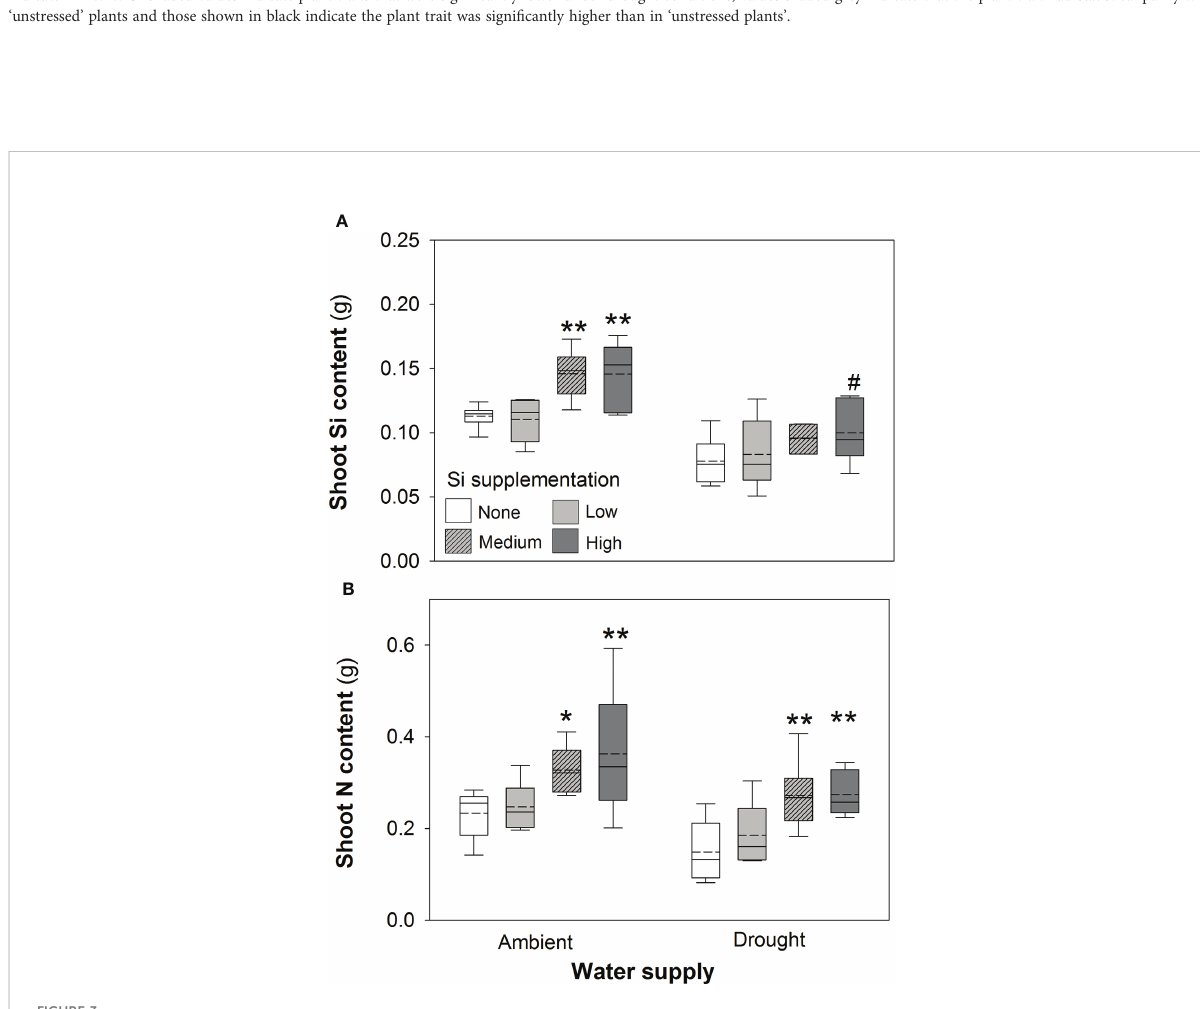
FIGURE 3 Shoot (A) Si and (B) N content of plants grown with Si supplementation (low, medium and high; 39, 78 and 117 kg ha -1 ) compared to plants without Si supplementation (none) under ambient and drought conditions (details as in Figure 2; N = 6). Statistically signi fi cant differences between Si supplemented plants and non-supplemented plants are indicated as * P < 0.05 and ** P < 0.01. Marginal non-signi fi cance ( P < 0.10) at the 95% con fi dence interval indicated